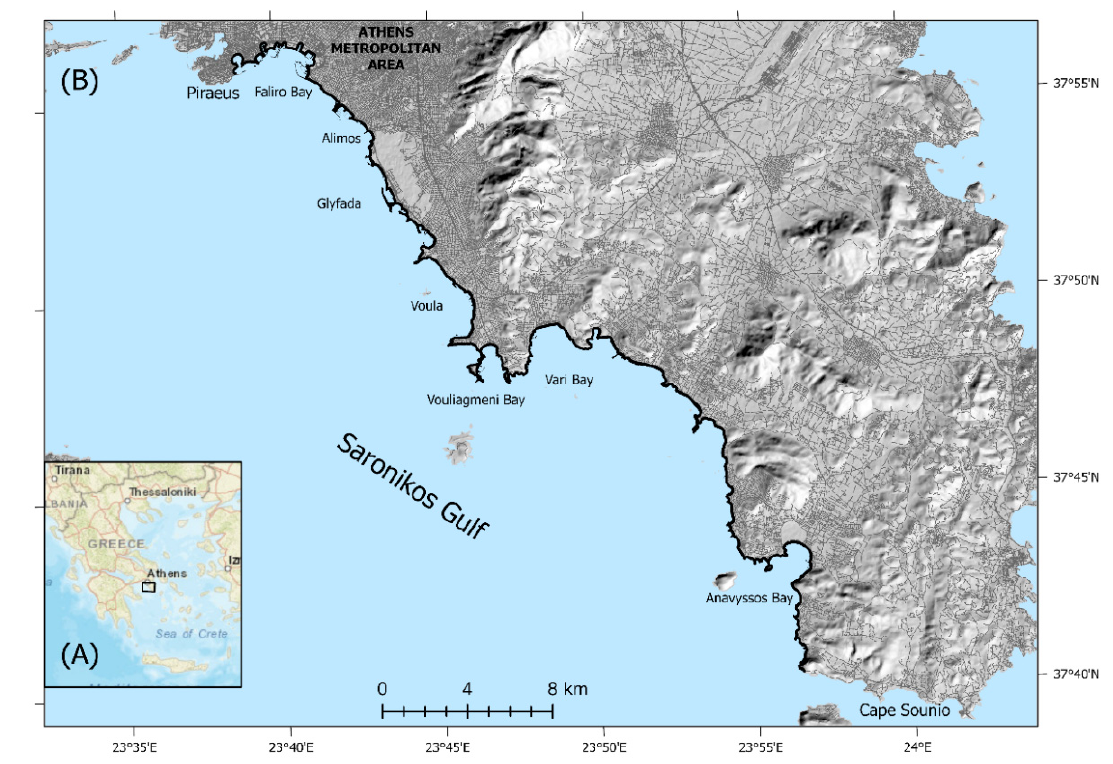
Figure 1. ( A ) Location map of the study area; ( B ) the elevations of the study area, the road network and the main towns.